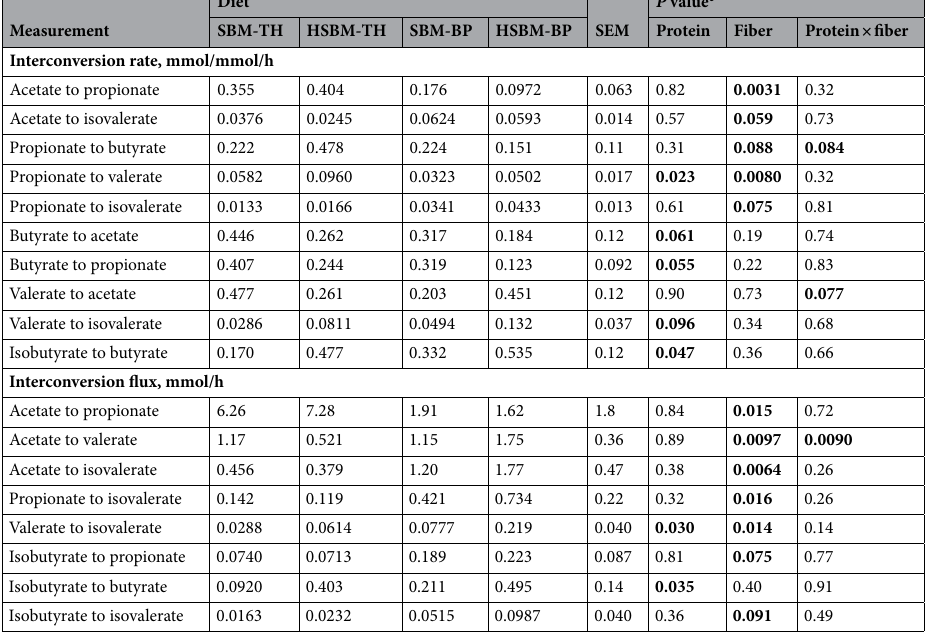
Table 5. LS means for significant and trending VFA interconversions as differentiated by diet along with P values for the effects of protein source, fiber source, and the interaction of protein and fiber source a,b